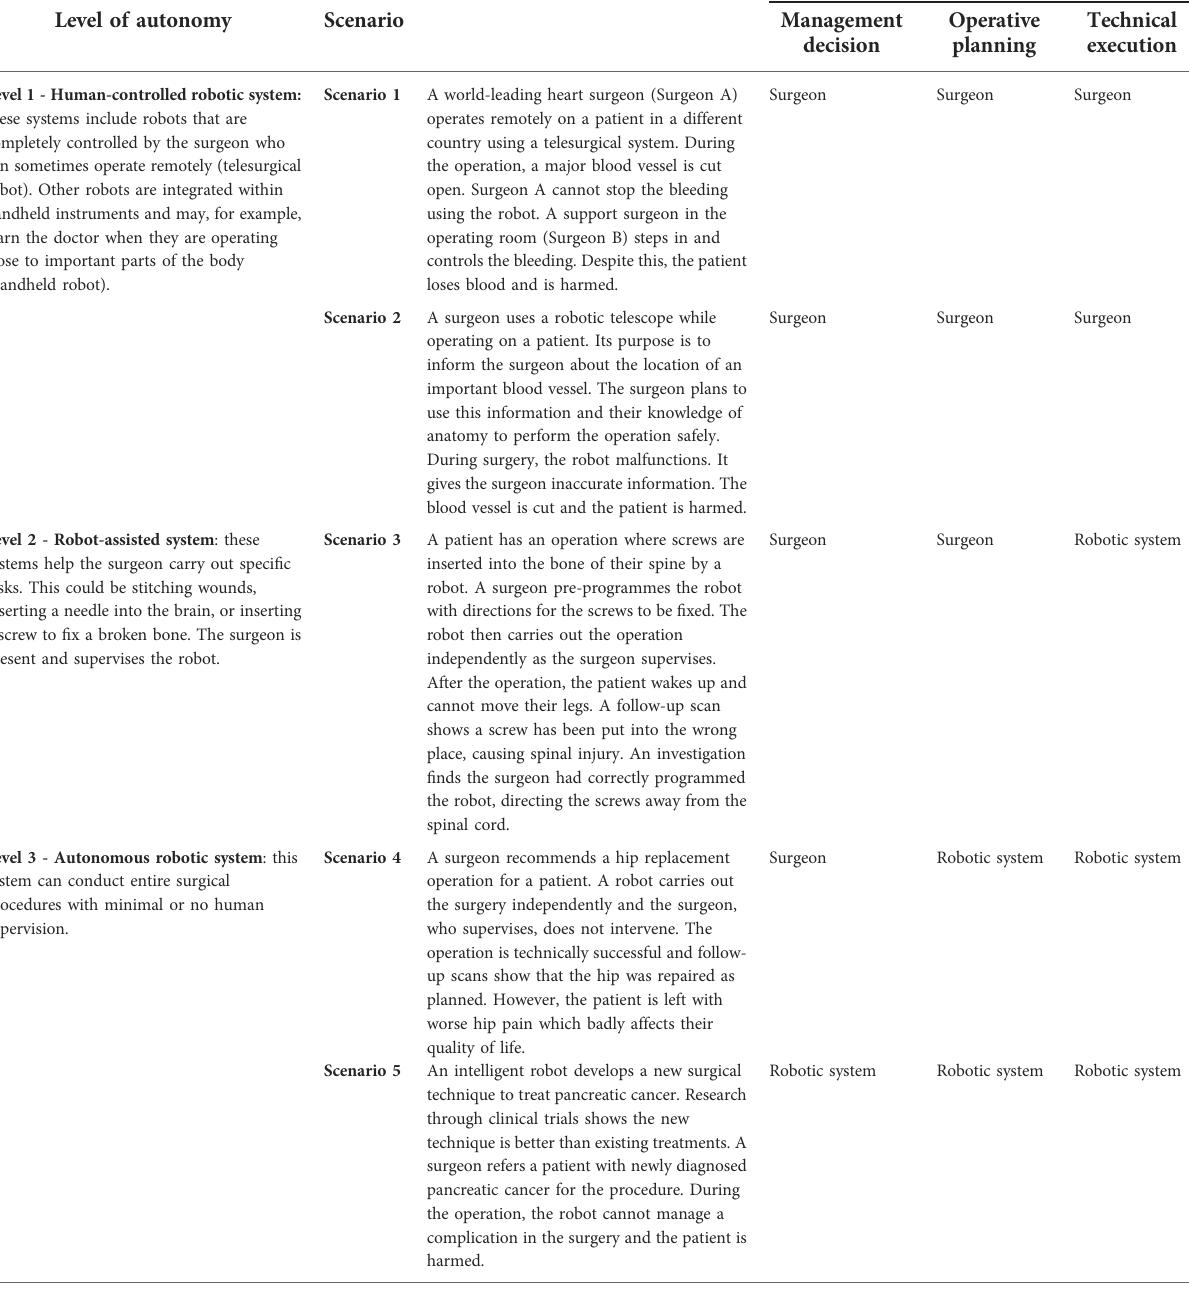
TABLE 1 Five scenarios describing robotic surgical systems with increasing